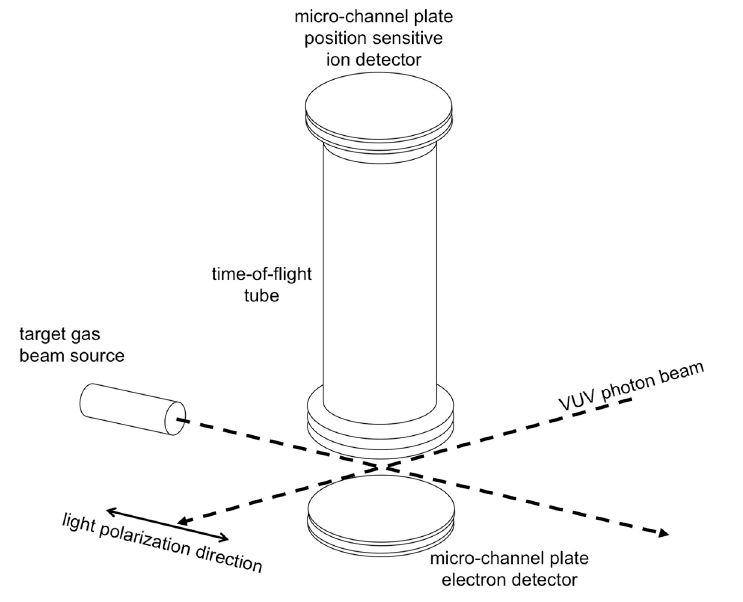
Figure 1. A scheme of the used electron-ion extraction and detection system used for the PEPIPICO measurements (see